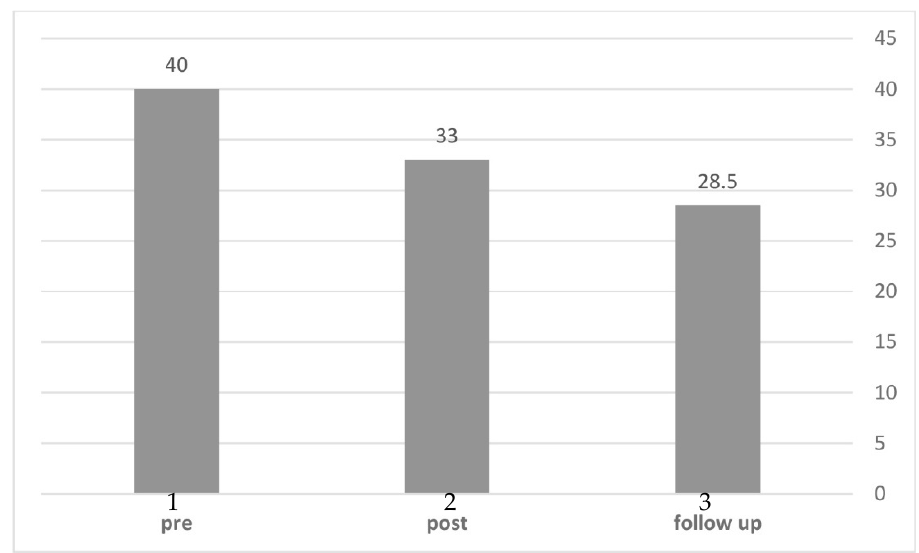
Figure 4. Rates (%) of Major Depressive Disorder in pre-, post- and follow-up assessments (MBSR group). Note: Pre-intervention (1); post-intervention (2); 6-month follow- up (3).